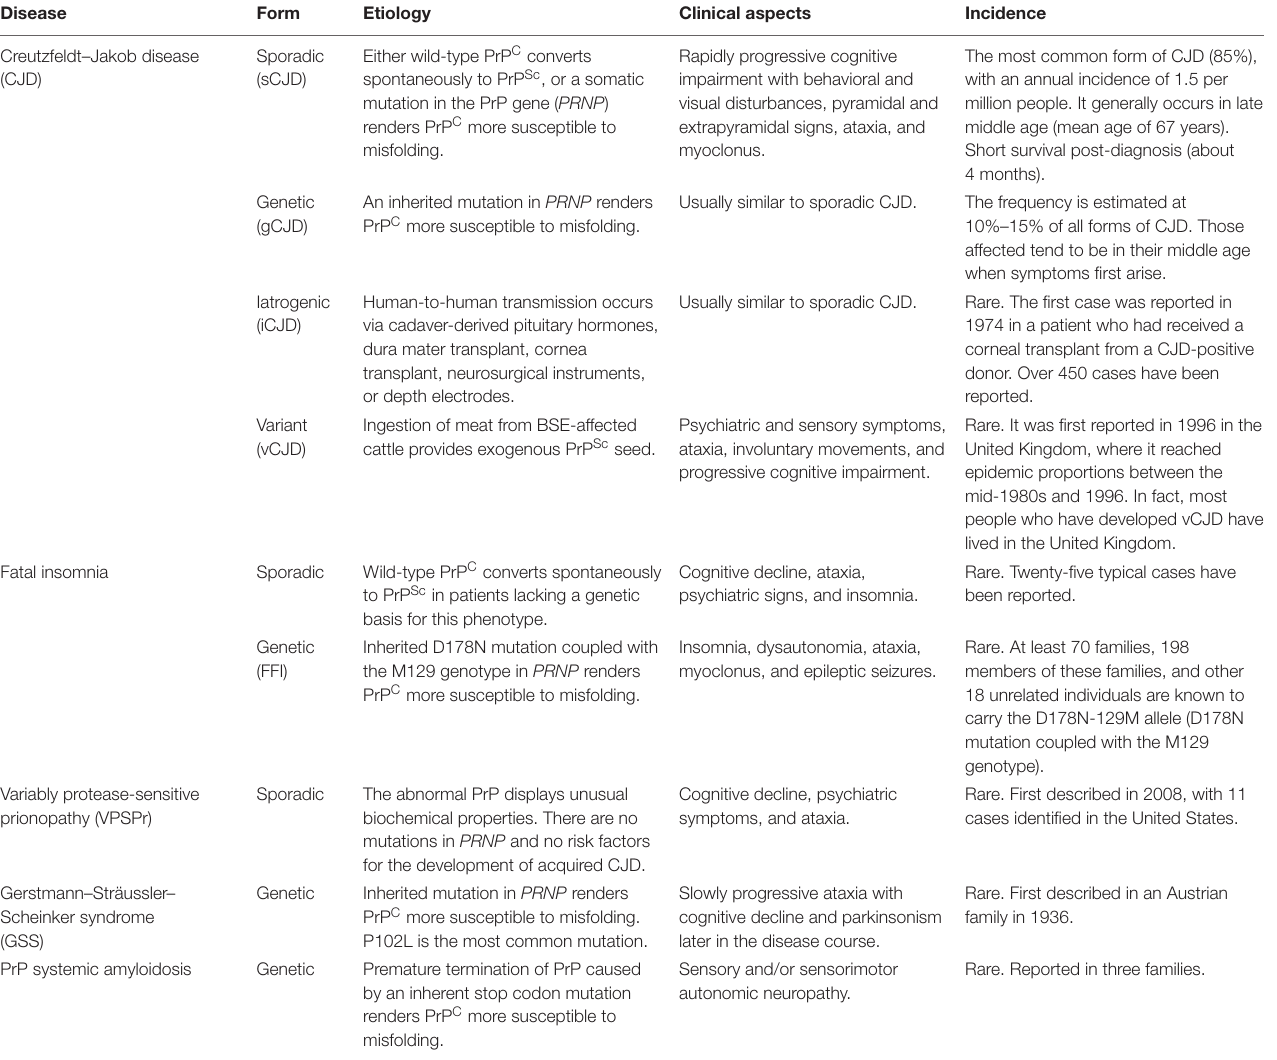
TABLE 1 | Transmissible spongiform encephalopathies